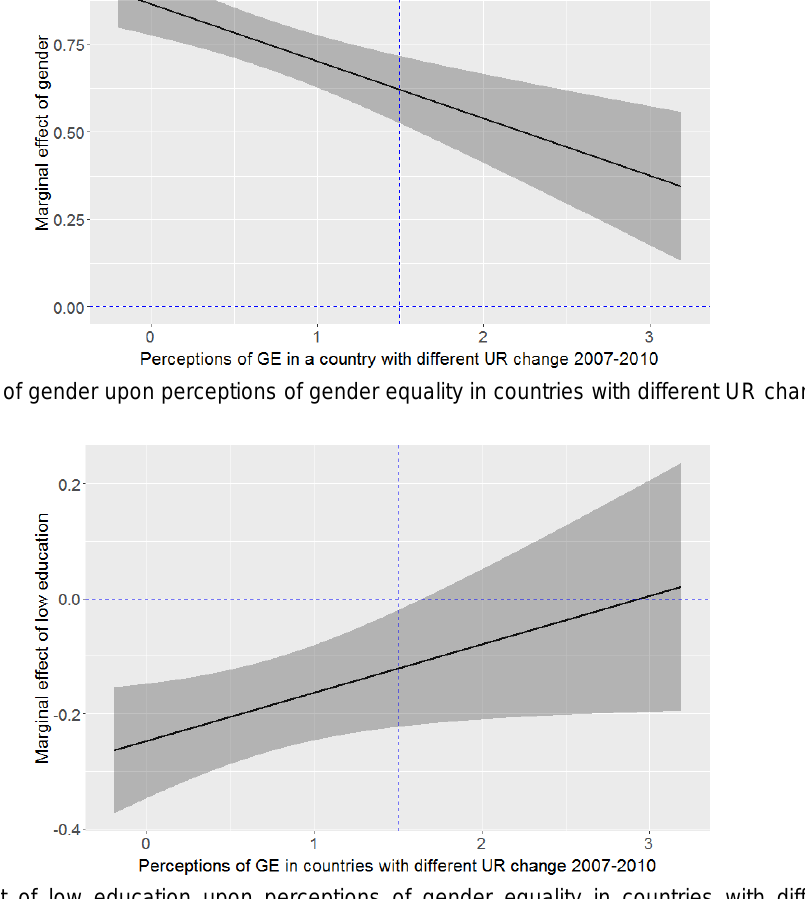
Figure 6 . Effect of low education upon perceptions of gender equality in countries with different UR change